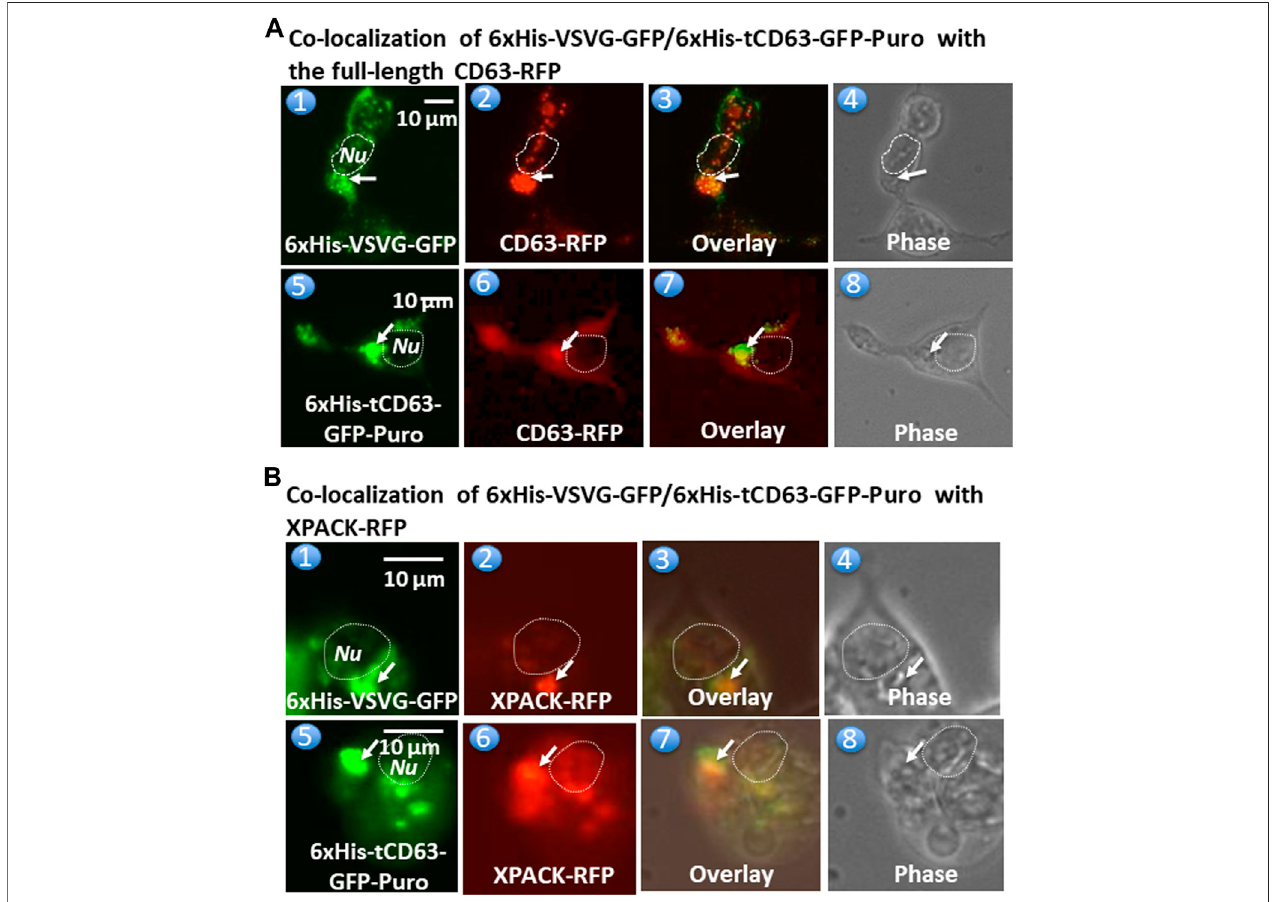
FIGURE 3 | Fusion proteins are targeted and integrated into exosome compartments. 293T cells were transiently transfected with either 6xHis-VSVG-GFP or 6xHis-tCD63-GFP in combination of established exosome marker: the full-length CD63-RFP or XPACK-RFP. Fluorescent and phase contrast images of the same fi eld were recorded on Day 2 post-transfection. Co-localization of either 6xHis-VSVG-GFP (top panel) or 6xHis-tCD63-GFP (lower panel) with full-length CD63-RFP, exhibitingpunctatesincytosols. (A) .Similarco-localizationpatternsofeither6xHis-VSVG-GFP(toppanels B )or6xHis-tCD63-GFP(lowerpanelsof B )withanother exosome marker, XPACK-RFP. (B) . Arrows indicated endosome/exosome/MVB structures; Dashed circle indicates nucleus ( Nu ). Scale bar, 10